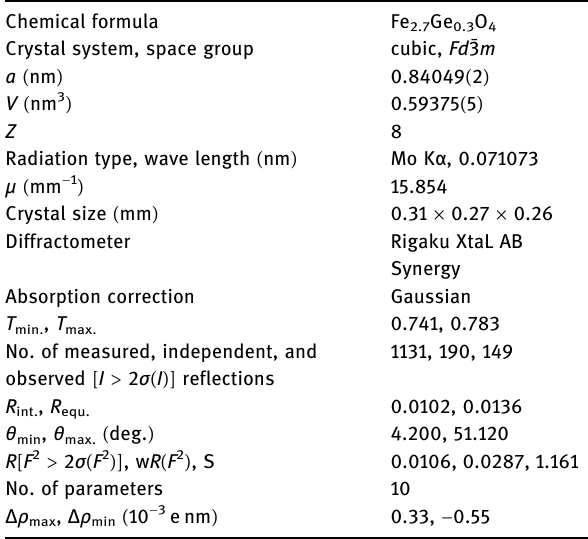
Table 1: Experimental details of single crystal X - ray diffraction